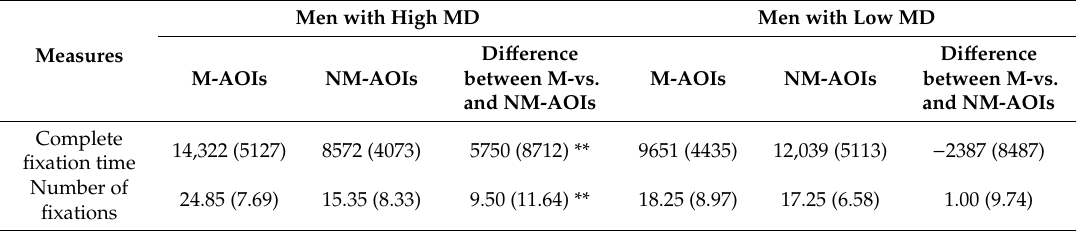
Table 1. Mean and standard deviation ( SD ) of the eye-tracking